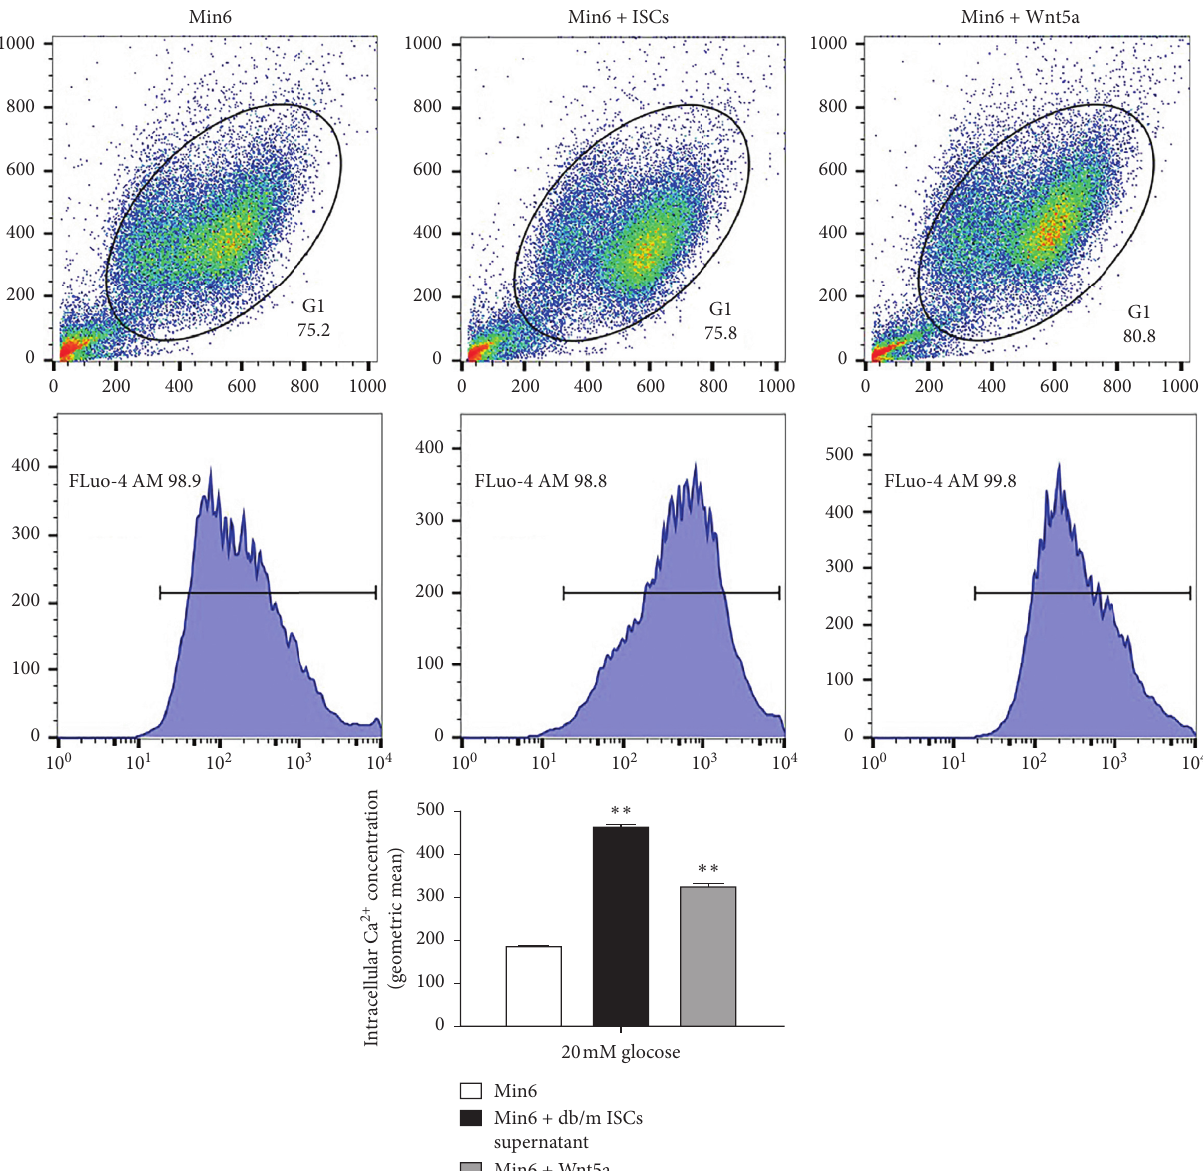
Figure 8: Intracellular Ca 2+ concentration in Min6 cells. Ca 2+ change in response to GSIS. Min6 cells cultured with ISC supernatant and with exogenous Wnt5a and loaded with 5 μ M Fluo-4 AM. Ca 2+ was measured in buffer and 20mM glucose was added to each well. n �